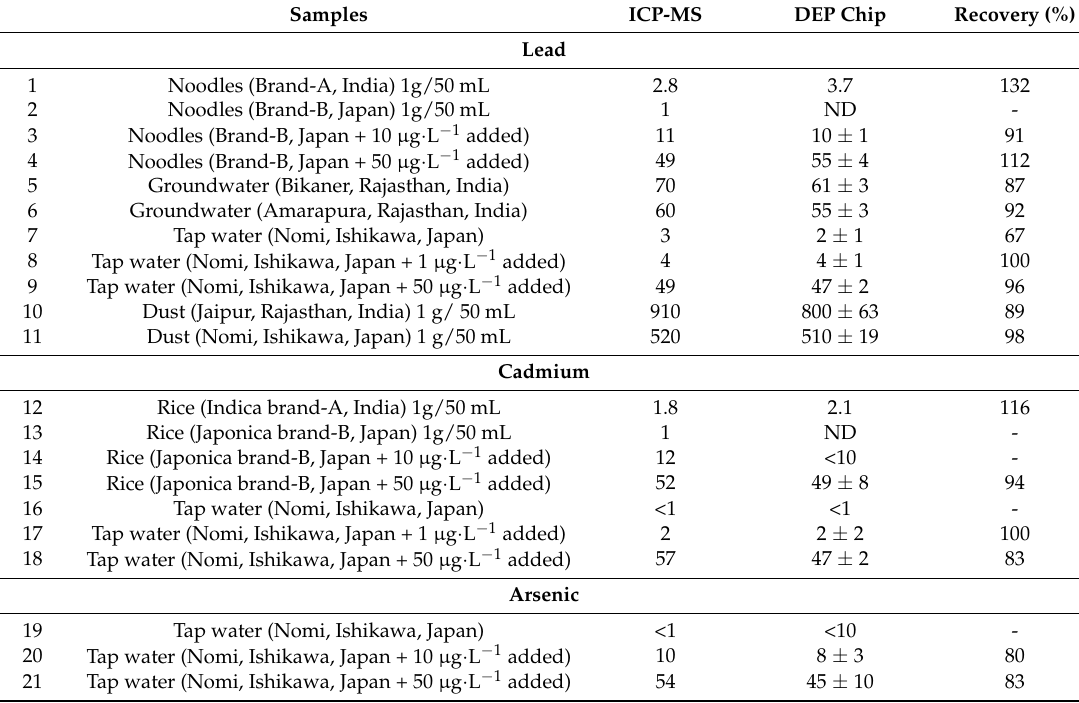
Table 2. A comparison of detecting heavy metals ( µ g · L − 1 added) in samples of water (groundwater, tap water), food (rice and noodles), and dust between ICP-MS and “DEP-On-Go”